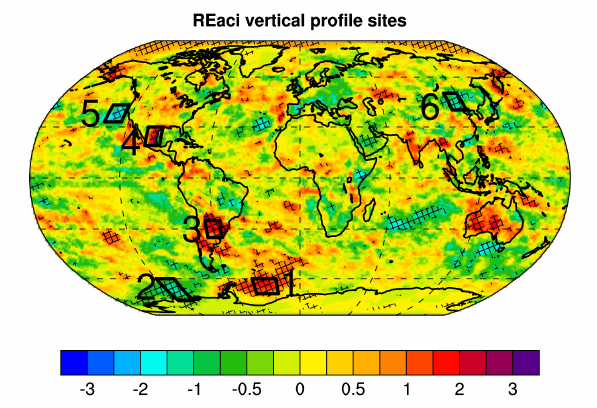
Figure 9. Locations of the vertical profile sites influenced by sig- nificant REaci in the BRC model run. Sites are referenced herein as (1) Weddell Sea (WS), (2) Antarctic coast (AC), (3) South America (SA), (4) Gulf of Mexico (GM), (5) northeast Pacific (NEP), and (6) northeastern China (NEC). Hatching indicates significance in the ensemble year change to the 0.1